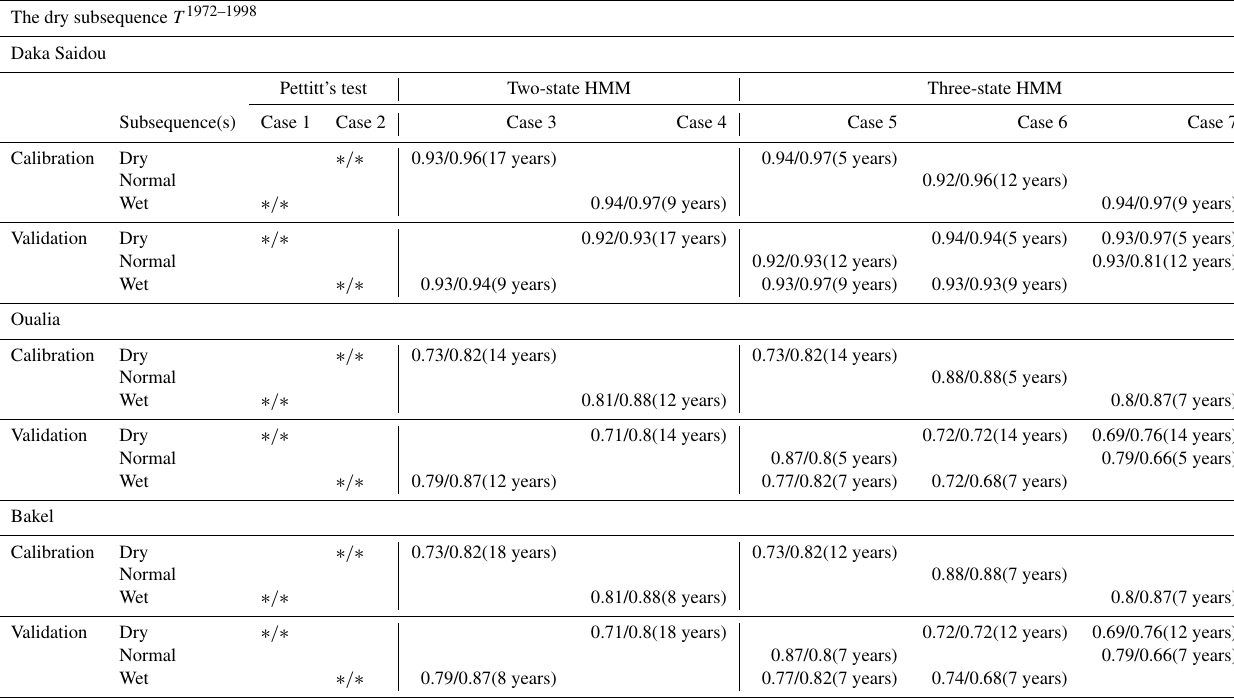
Table 7. Table of NSE/KGE calibration and validation scores according to the seven cases for the dry subsequence T 1972–1998 . As Pettitt’s test is not conclusive here, no calibration/validation scores are given (symbols ∗ / ∗ ). The dry subsequence T